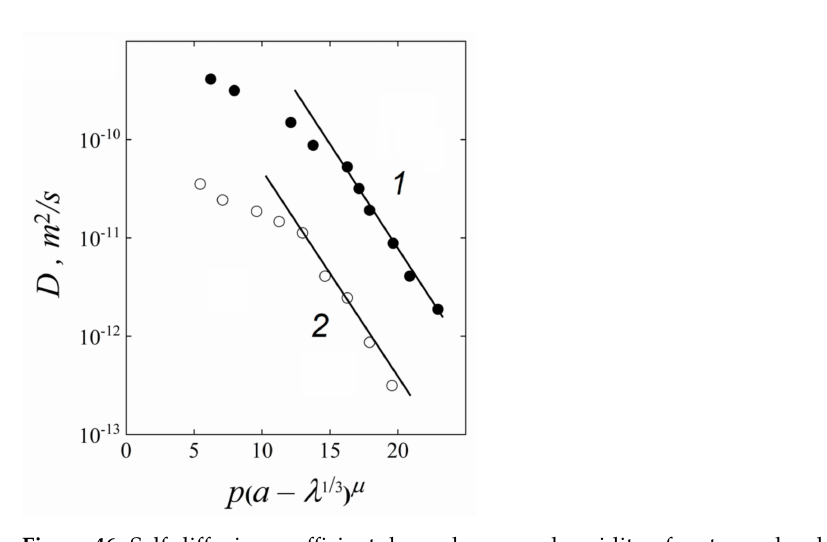
Figure 46. Self-diffusion coefficient dependences on humidity of water molecules (1) and lithium cations (2). Reprinted with permission from [39]. Copyright 2002 Springer